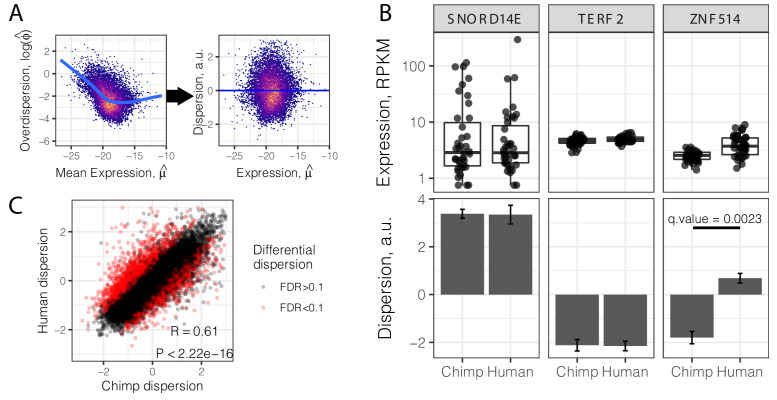
Gene variance independent of expression is correlated across species.(A) To estimate dispersion, RNA-seq counts for 39 human heart tissue samples were used to estimate gene-wise mean (μ) and overdispersion (ϕ) parameters. Across all genes, overdispersion is correlated with mean expression (left) in the hexbin scatter plot. We regressed out this correlation, using the residual of a LOESS fitted line (blue) as a metric (dispersion) of the variability of a gene’s expression across a population relative to similarly expressed genes (a.u., arbitrary units). (B) Dispersion estimates and the underlying expression in each sample for three similarly expressed genes in human and chimpanzee. Error bars represent bootstrapped standard error. Q-value for ZNF514 represents an estimate of FDR after genome-wide multiple hypothesis testing correction. (C) Dispersion estimates across all genes are correlated across human and chimpanzee, despite identification of thousands of differentially dispersed genes in red. R and p-value correspond to Pearson’s correlation. Full dispersion estimates and differential dispersion results available as Figure 2—source data 1.Figure 2—source data 1.Gene-wise dispersion estimates and differential testing.